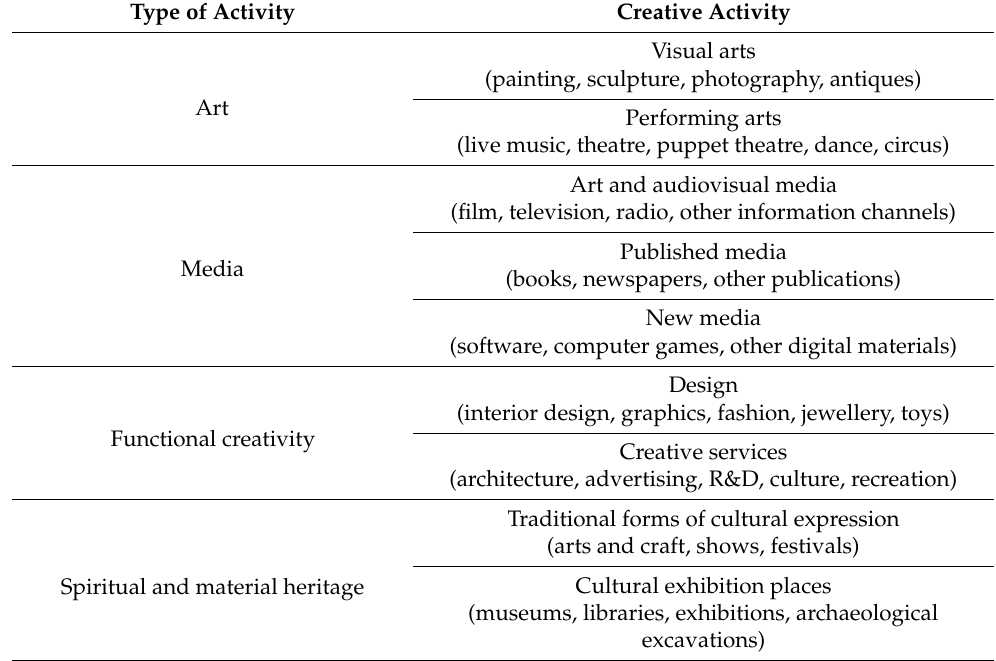
Table 1. Classification of creative activities according to